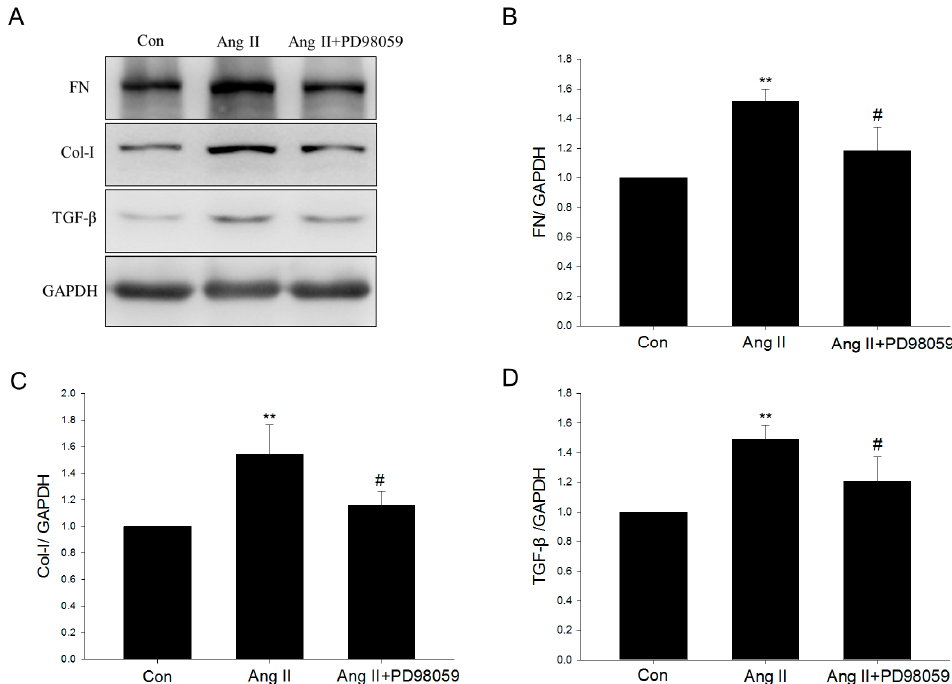
Figure 9. Effect of ERK inhibitor PD98059 on angiotensin II–induced profibrotic effects. ( A – D ) After 48 h of Ang II treatment, with or without 1 h ERK inhibitor PD98059 pretreatment. Fibronectin (FN), collagen I (Col-I), and TGF- β were assayed by Western blot analysis. Data are the mean ± SEM of three experiments. * p < 0.05, ** p < 0.01 compared with control (Con); # p < 0.05 compared with Ang II only.